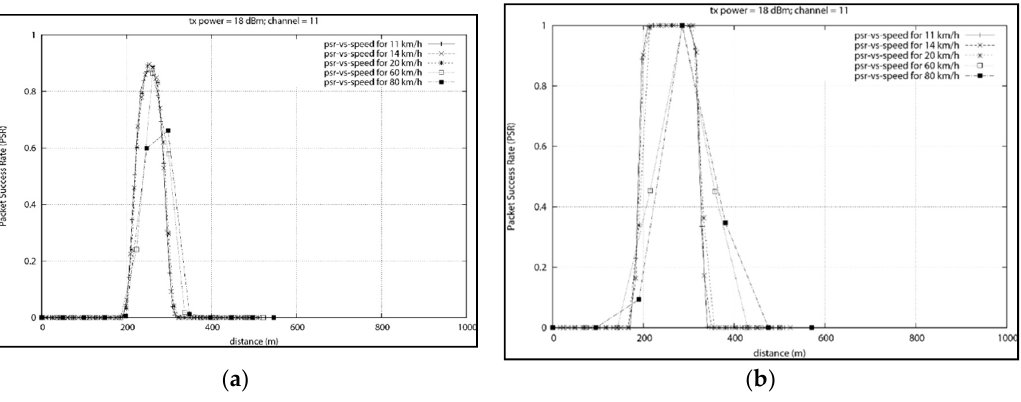
Figure 26. Speed vs. reliability for concentrator on buildings in busy area (4.0 path loss exponent) ( a ) 60 m high, ( b ) 90 m high.